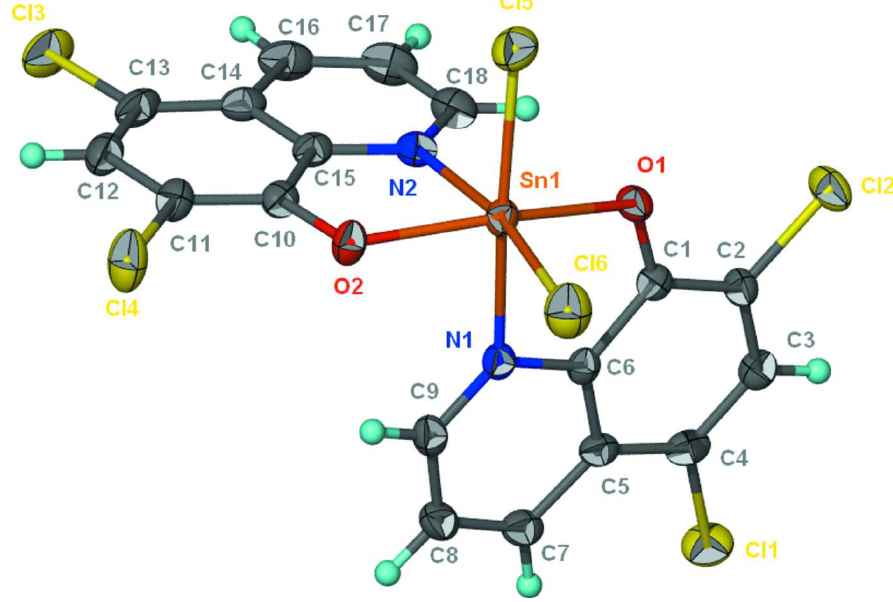
(C H Cl NO) ; ellipsoids are drawn at the 70% 2 9 4 2 2